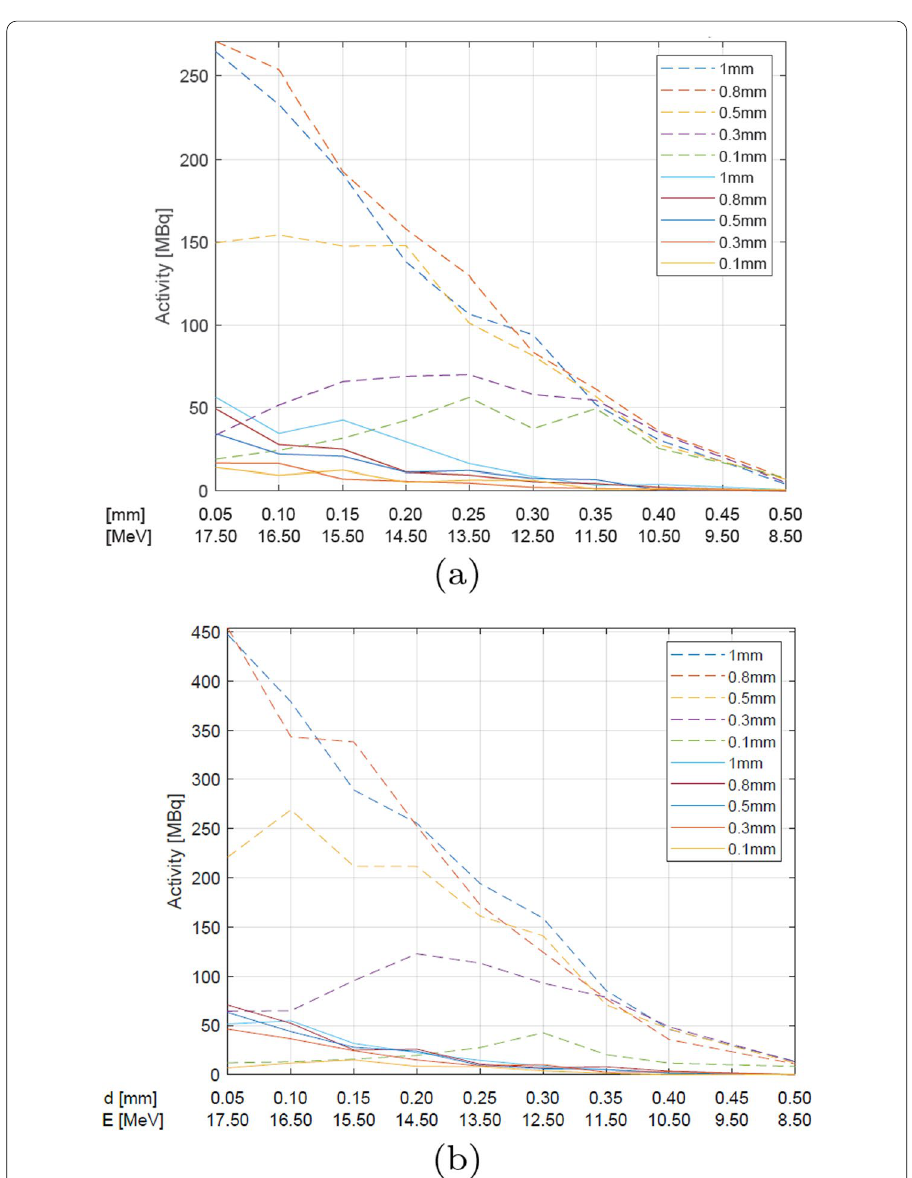
Fig. 6 The simulated activity changes of 124 I from natural (straight line) and enriched (dashed line) TeO 2 for various various target thicknesses (denoted by various colors as shown in the legend) and various Molybdenum foil thickness at the proton current of a 10 μA and b 15